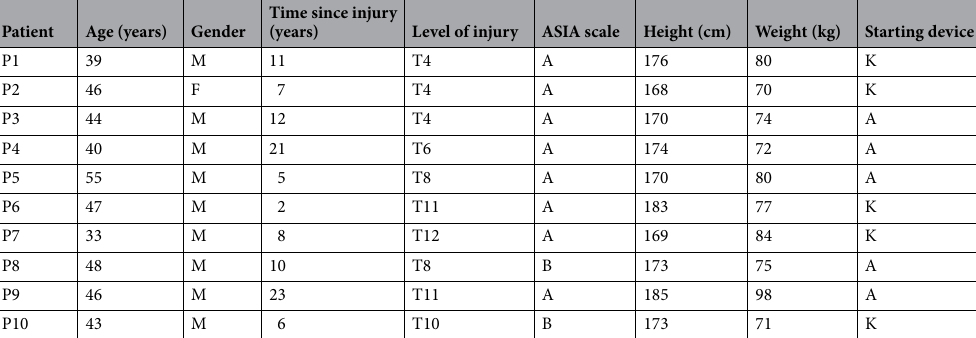
Time since injury Age (years) Gender (years) Level of injury ASIA scale Height (cm) Weight (kg) Starting device